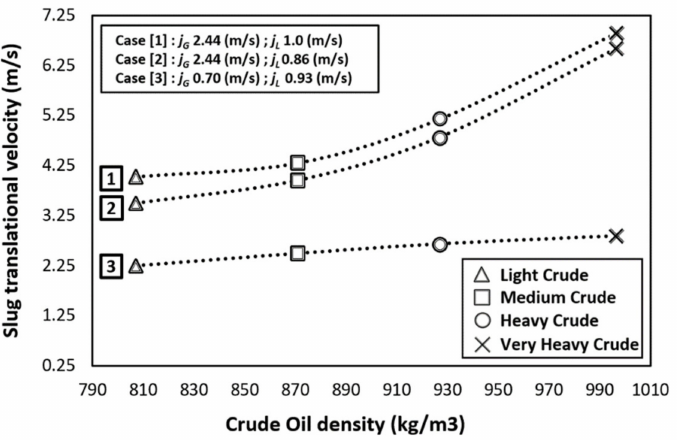
Figure 13. Effect of varying crude oil grades on slug translational velocity.